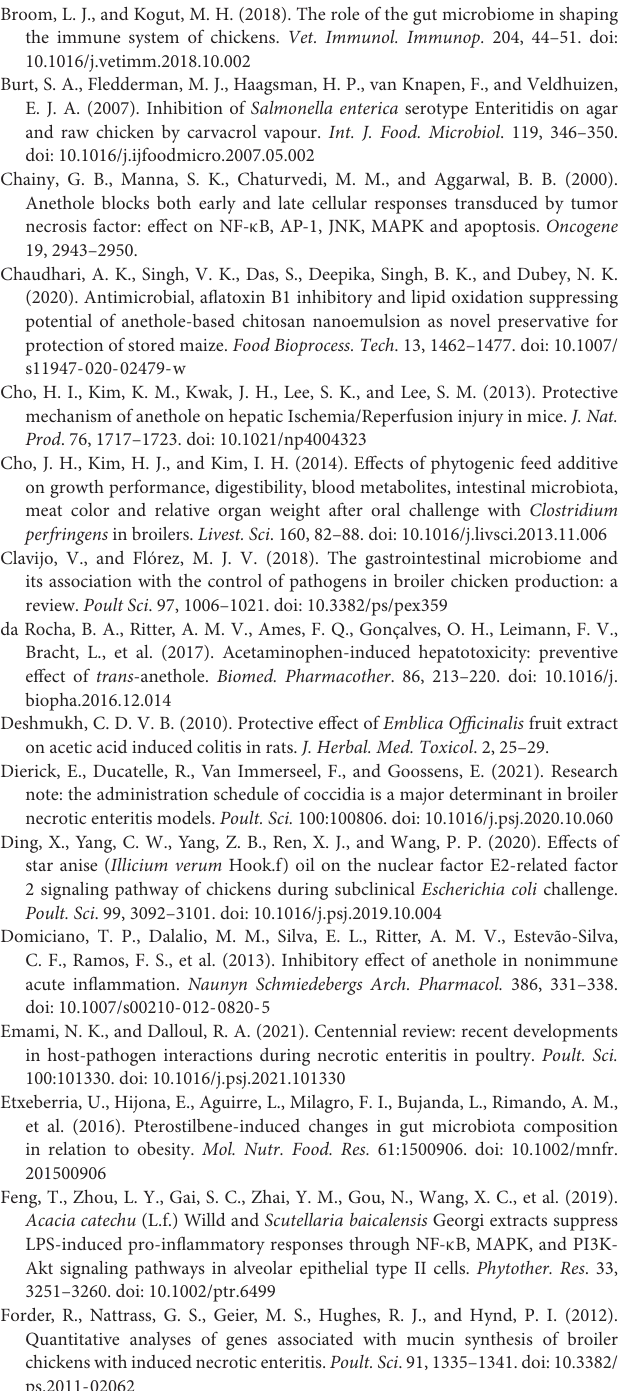
Supplementary Figure 1 | Rarefaction curve of the cecal microbiota based on operational taxonomic units (OTUs). Supplementary Figure 2 | Significant differences on phylotypes at the genus level were observed between the CON and NE + TA400 groups (A) and the CON